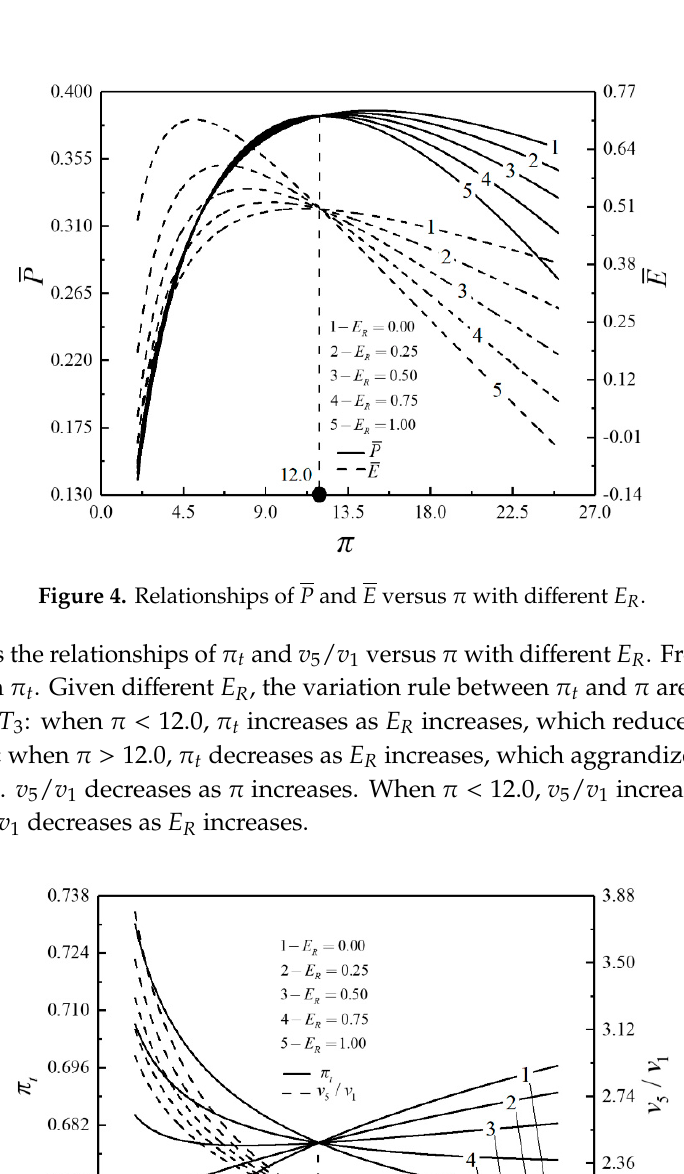
10 of 22 Figure 3. Relationships of W and η versus π with different R E . Figure 5 shows the relationships of t π and R E . From Figure 5,